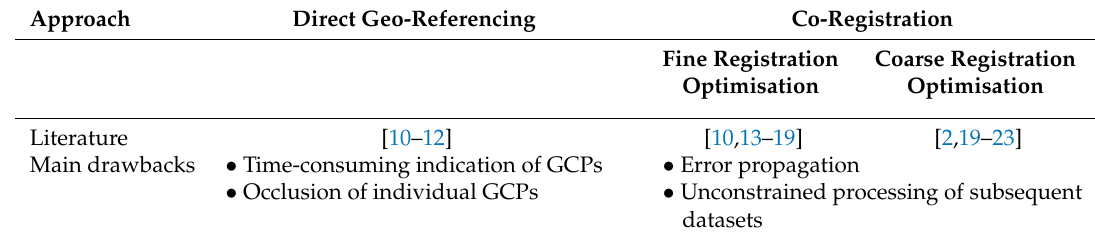
Table 1. Major works on methods for geo-referencing consecutive datasets and the main